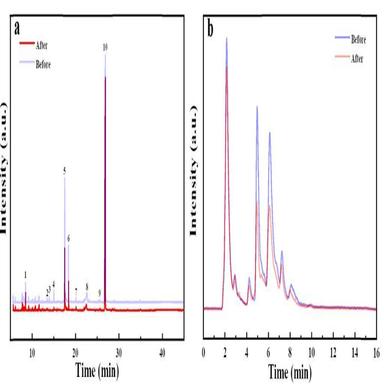
Comparison of gas (a) and liquid (b) chromatograms of the green tea extract reaction solution: (blue) before (fresh); and (red) after Fe–Mn NPs synthesis.